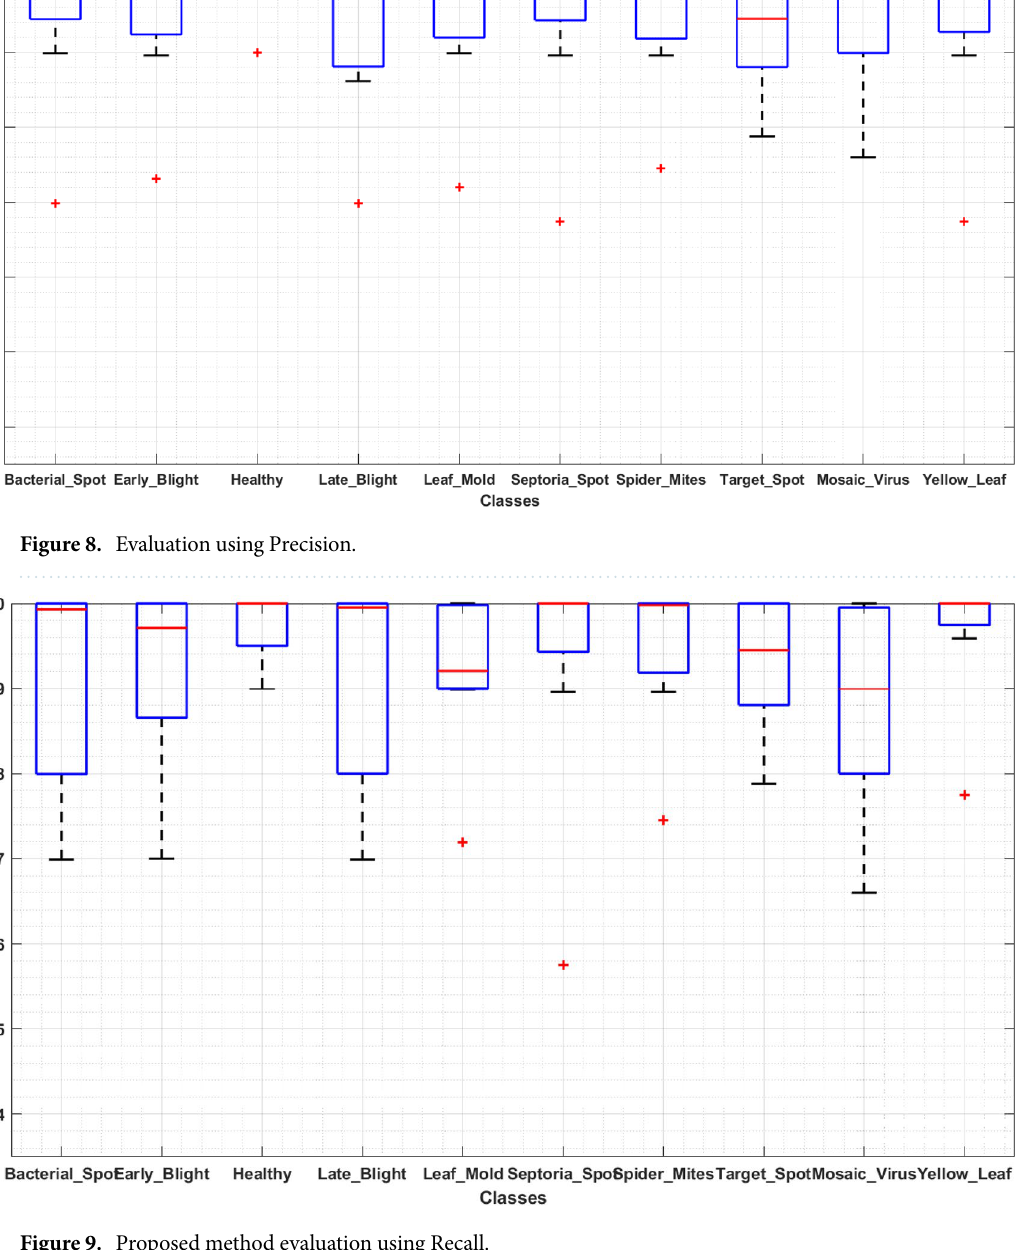
Figure 9. Proposed method evaluation using